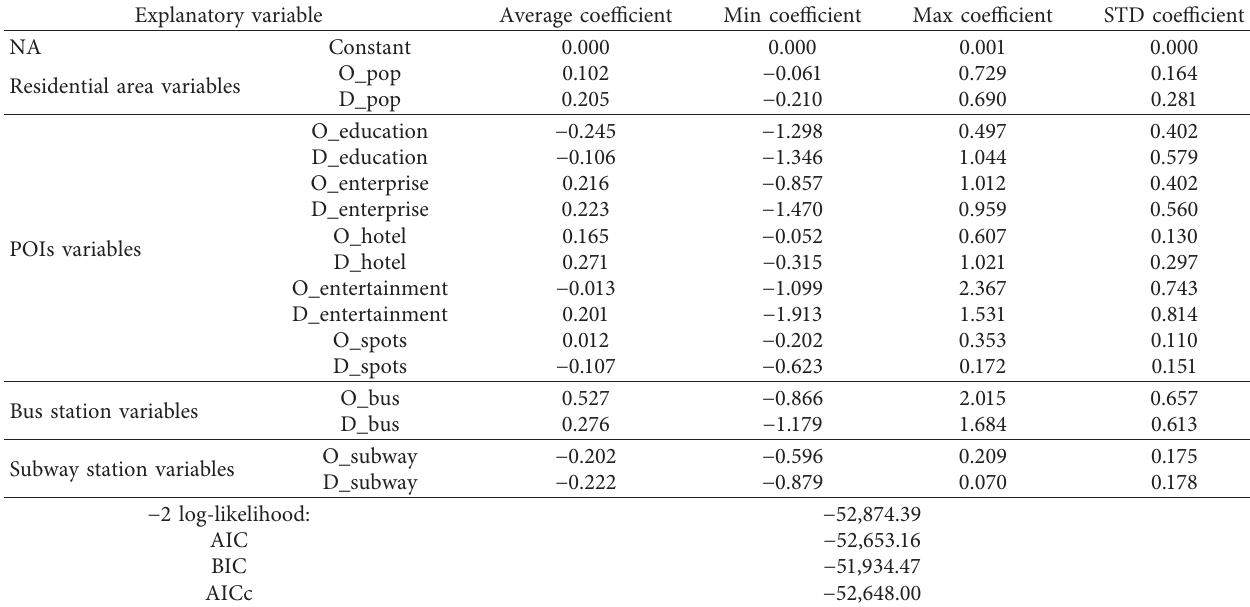
Table 5: Estimation results of the GWR